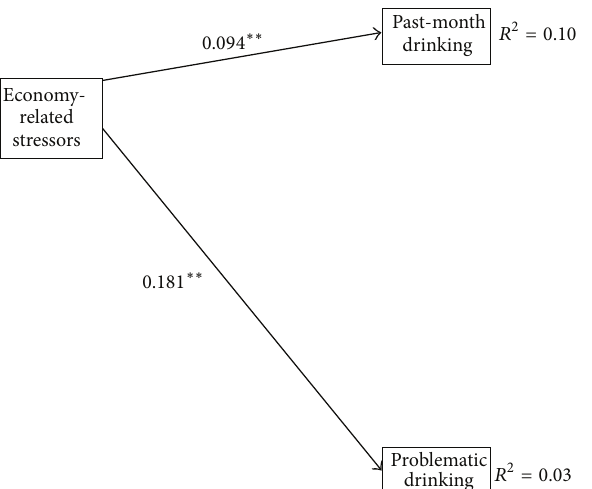
Figure 2: Structuralequation model relating economy-related stressorsto alcohol-related outcomes. Notes: standardized parameter estimates are reported. Model controls for gender, age, education, and race/ethnicity. ∗ significant at 0.05; ∗∗ significant at 0.01; ∗∗∗ significant at